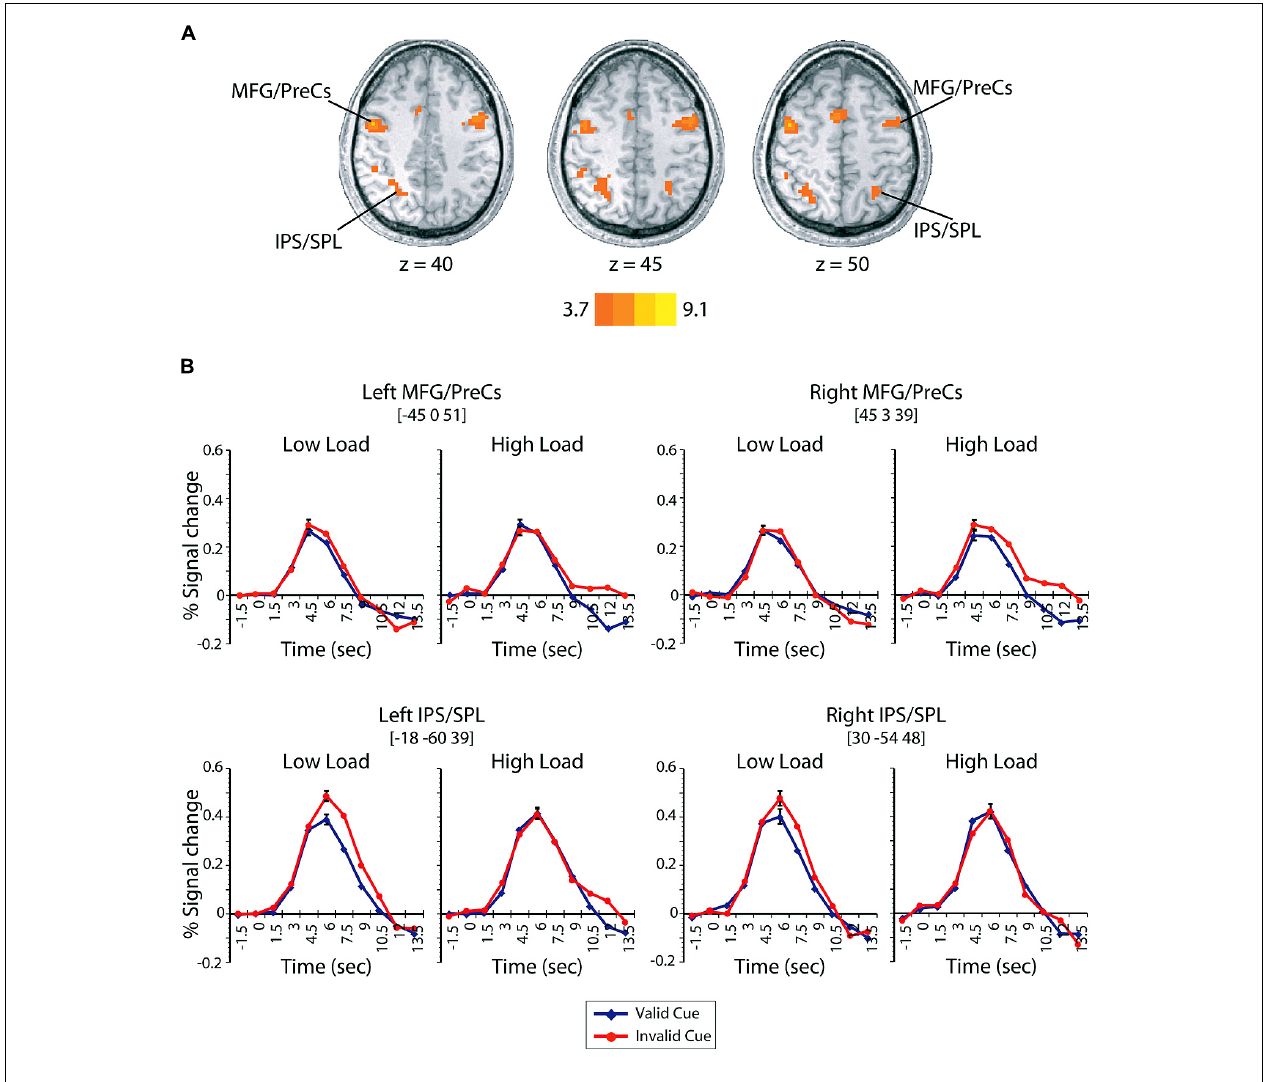
FIGURE 3 | (A) Regions demonstrating greater activations in cue-only trials compared to null-event baseline. The left side of the brain is depicted on the left side of the figure. Scale corresponds to the t -value. (B) Time-course of BOLD signals on valid (blue) and invalid (red)